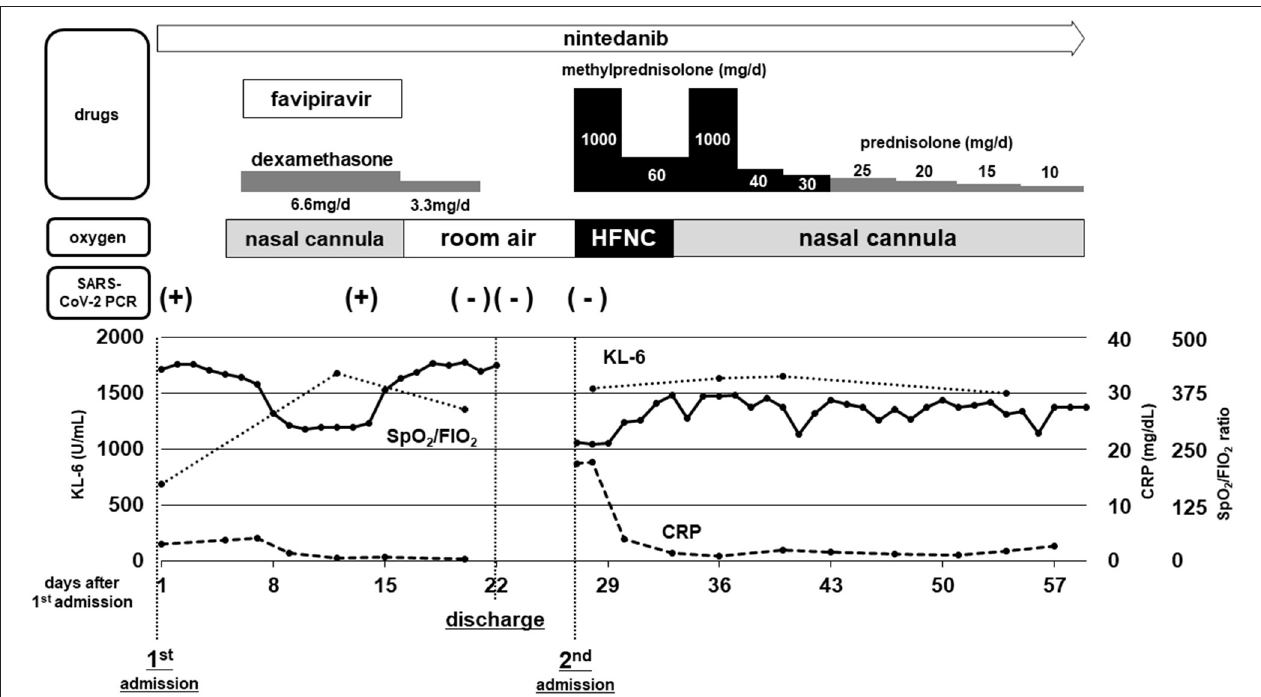
FIGURE 2 | Schematic chart of clinical course and treatment. Therapeutic regimen and the dosages of drugs for COVID-19 and IPF/AE-IPF are shown at the top. The methods of oxygen supplementation required for the patient and the results of SARS-CoV-2 RT-PCR tests are shown in the middle. Changes in serum levels of C-reactive protein (CRP) and Krebs von den Lungen-6 (KL-6), along with the oxygenation index (ratio of SpO 2 /FIO 2 ) are depicted in the bottom